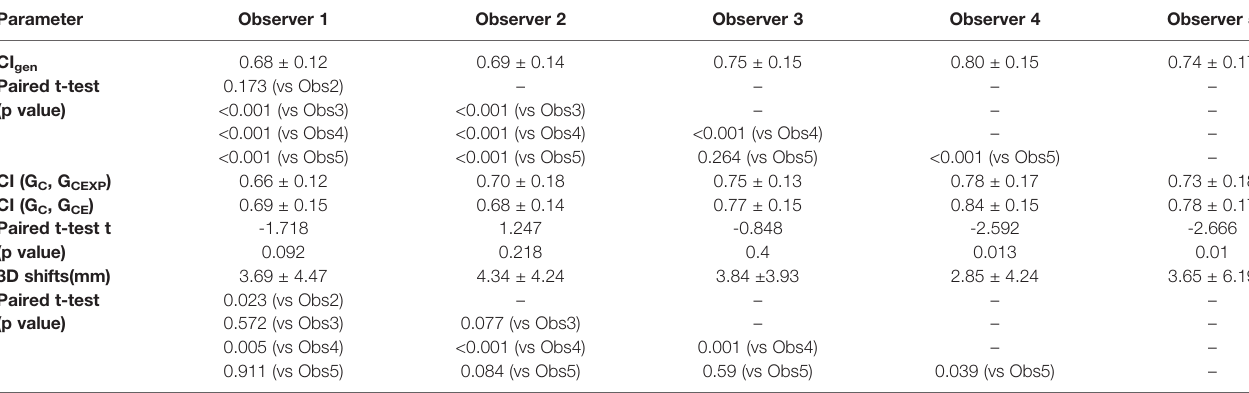
TABLE 4 | The CI gen values and 3D centroid shifts (Mean ± SD) of the four GTVs derived from different combinations of multimodal imaging for each